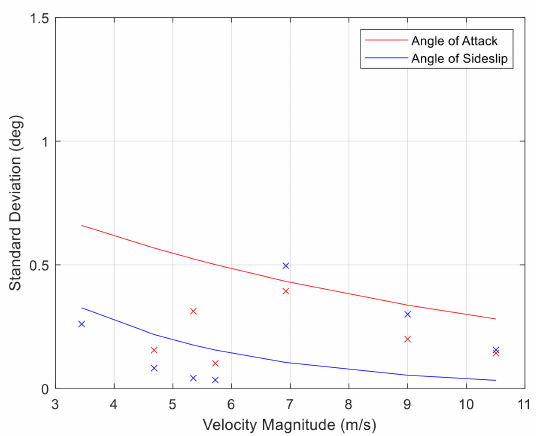
Figure 18. The standard deviation of the angle of attack and sideslip vs. magnitude of the relative velocities: numerical values and least-square